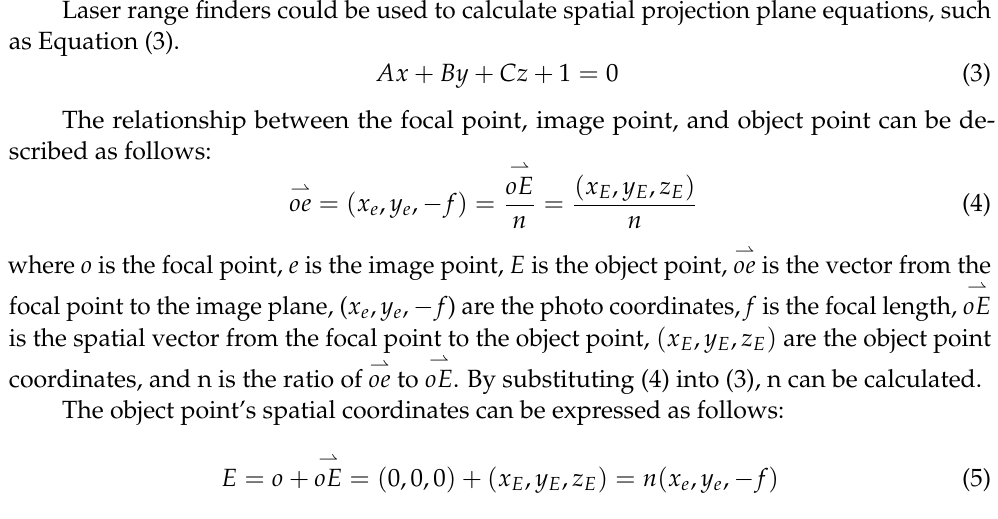
Figure 9. Spatial relationships between the photo projection vector and projection plane.